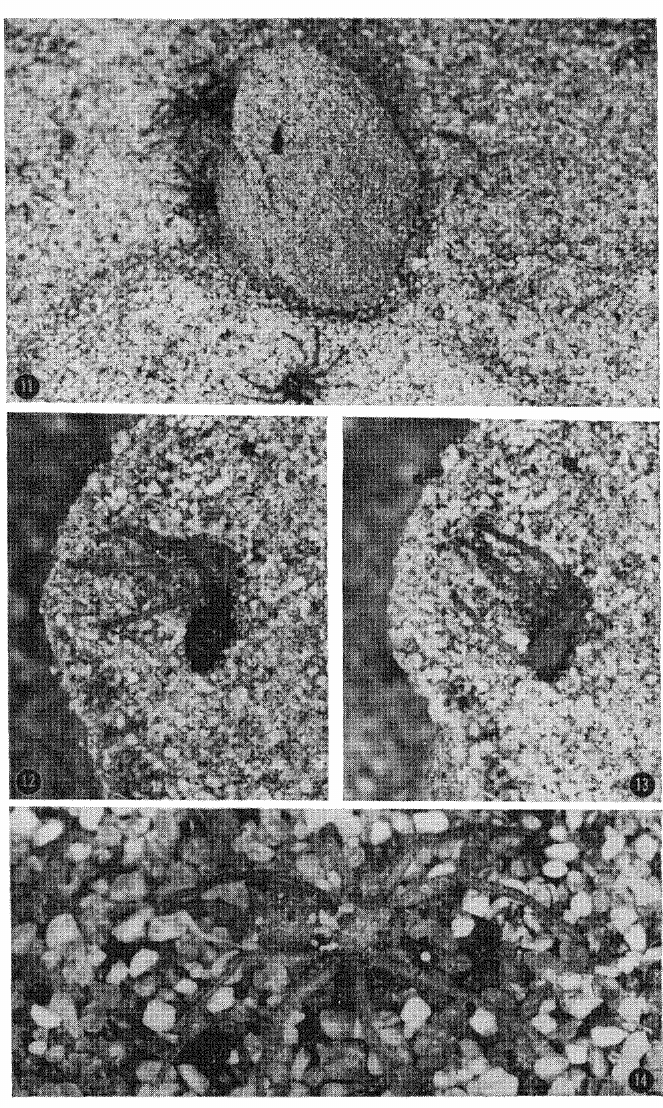
Fig. 11. The eggcase after the young have started to emerge. To facili- tate photographing, the eggcase was removed from its attachment to the wall and placed on sand. The hole is near the upper edge. Several young, each about 2.5 mm long, are seen on the sand. Fig. 12. One after another the young spiderlings emerge from the hole. The legs .appear first. Fig. 13. The body moves sideways through the hole. Fig. 14. The young already have some sand grains clinging to their bodies. This individual left the eggcase when it was taken off the wall, and still has an exuvium attached to the